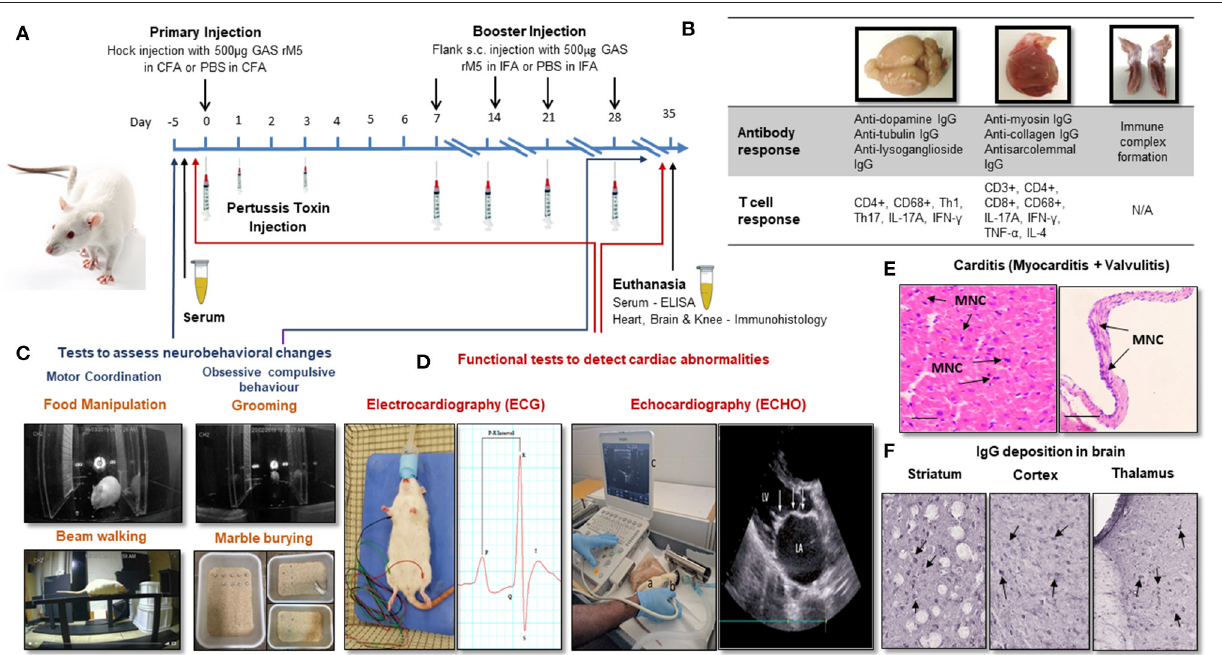
injection with whole-killed GAS or recombinant GAS M proteins induced tissue cross-reactive antibodies and T cells (26, 27, 30, 31, 33, 34, 46, 48). Moreover, the involvement of Th-17 cells and